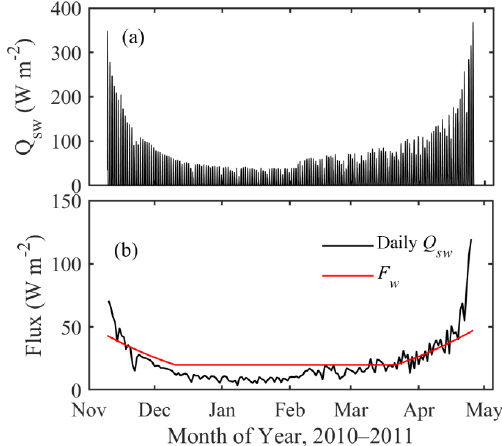
Figure 9. Modeled solar radiation penetration ( Q sw ) into the under- ice water column: hourly (a) and daily averages (b) with prescribed F w during the simulation period.